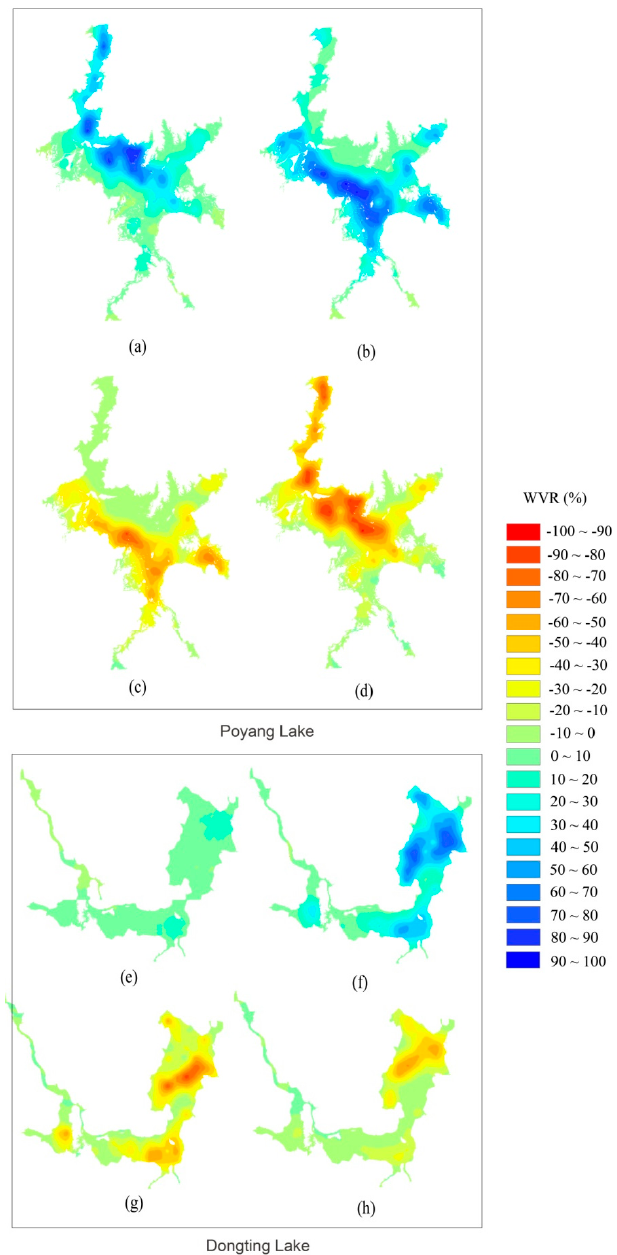
Figure 8. Spatial distributions of the water variation rates of water inundation in the two lakes. Variations in the water surface of: Poyang Lake ( a – d ); and Dongting Lake ( e – h ) during the low-water to rising period, rising to high-water period, high-water to retreating period, and retreating to low-water period, respectively. Water expansion is shown in blue, and water shrinkage is shown in red.